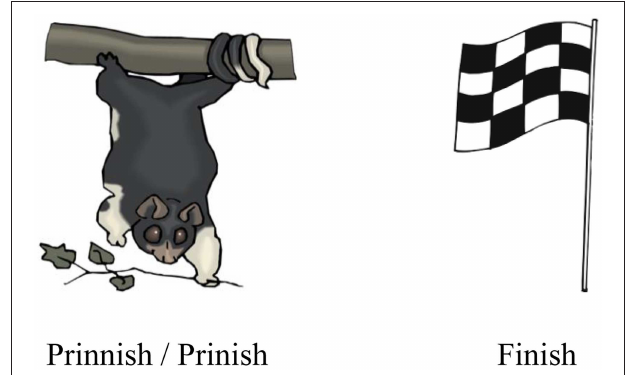
FIGURE 1 | Example of images associated to the corresponding word (right) and C- and CC-pseudowords